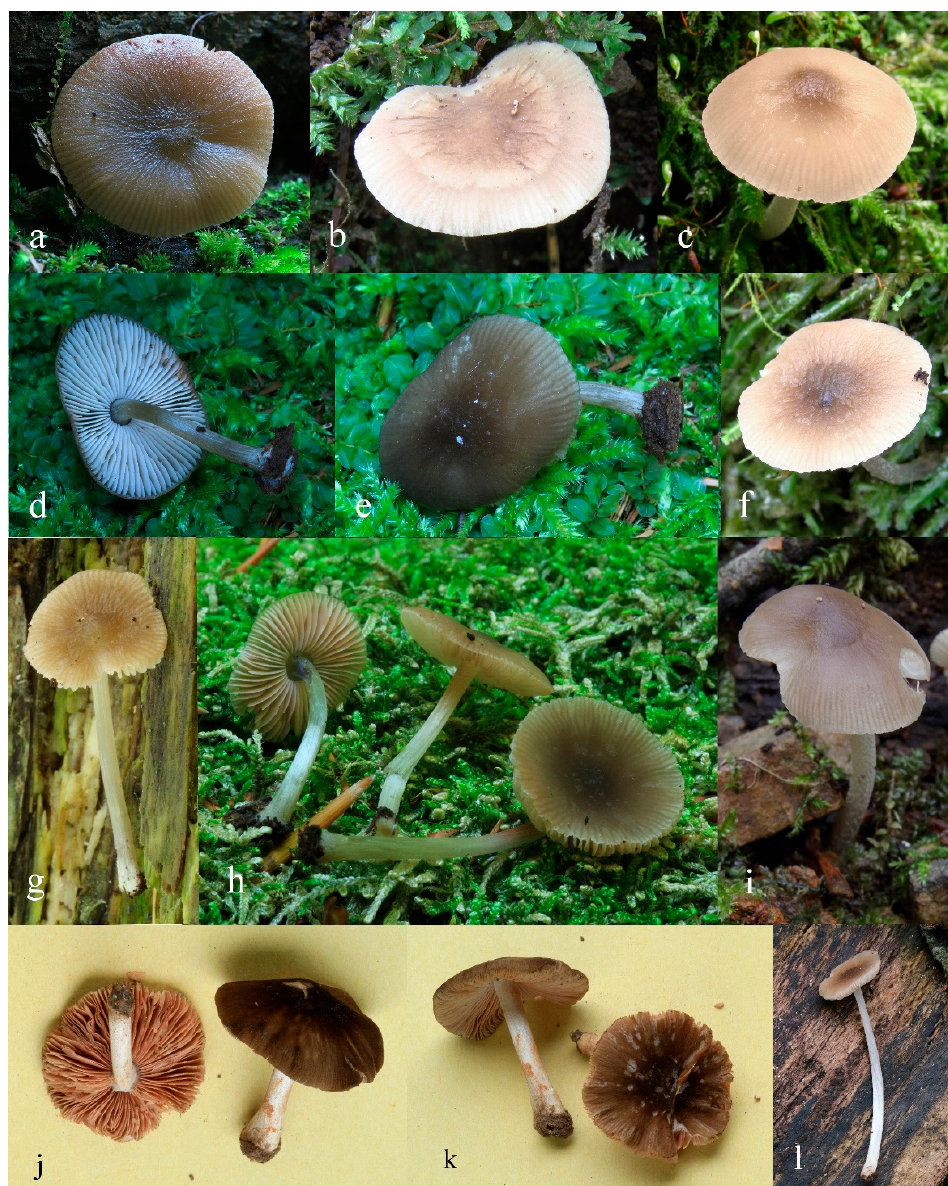
Figure 13. Pluteus reisneri basidiomata: ( a ) epitype BRNM781263; ( b ) FG24062020013; ( c ) FG14092019062; ( d , e ) BRNM781265; ( f ) FG13102019047; ( g ) BRNM808902; ( h ) BRNM817756; ( i ) FG26092019042; ( j , k ) BRNM825833; ( l ) OKA-TR1823.